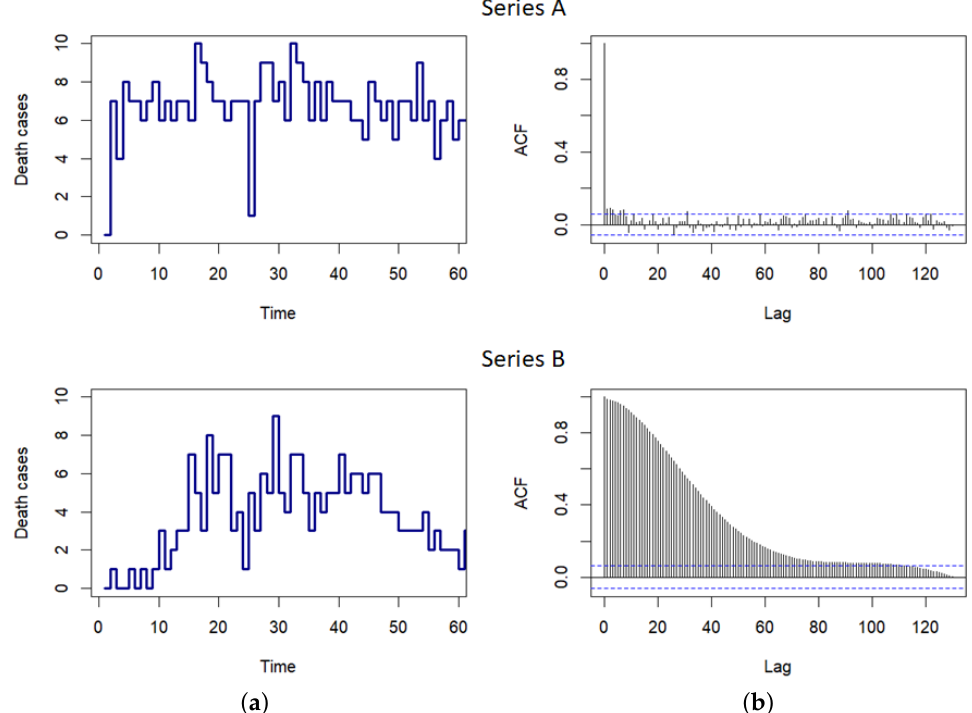
Figure 4. ( a ) Dynamics of the number of deaths before and after the onset of the disease COVID-19 in Serbia. ( b ) The corresponding ACFs of the observed time